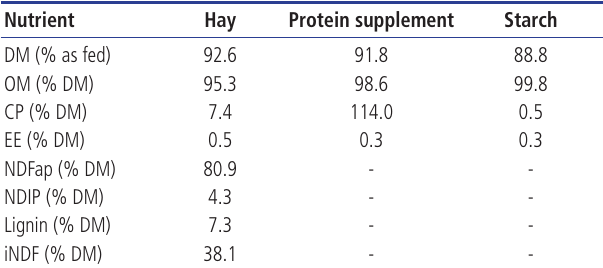
Table 1. Chemical composition of tropical hay, and two supplements (protein supplement and starch) Nutrient Hay Protein supplement